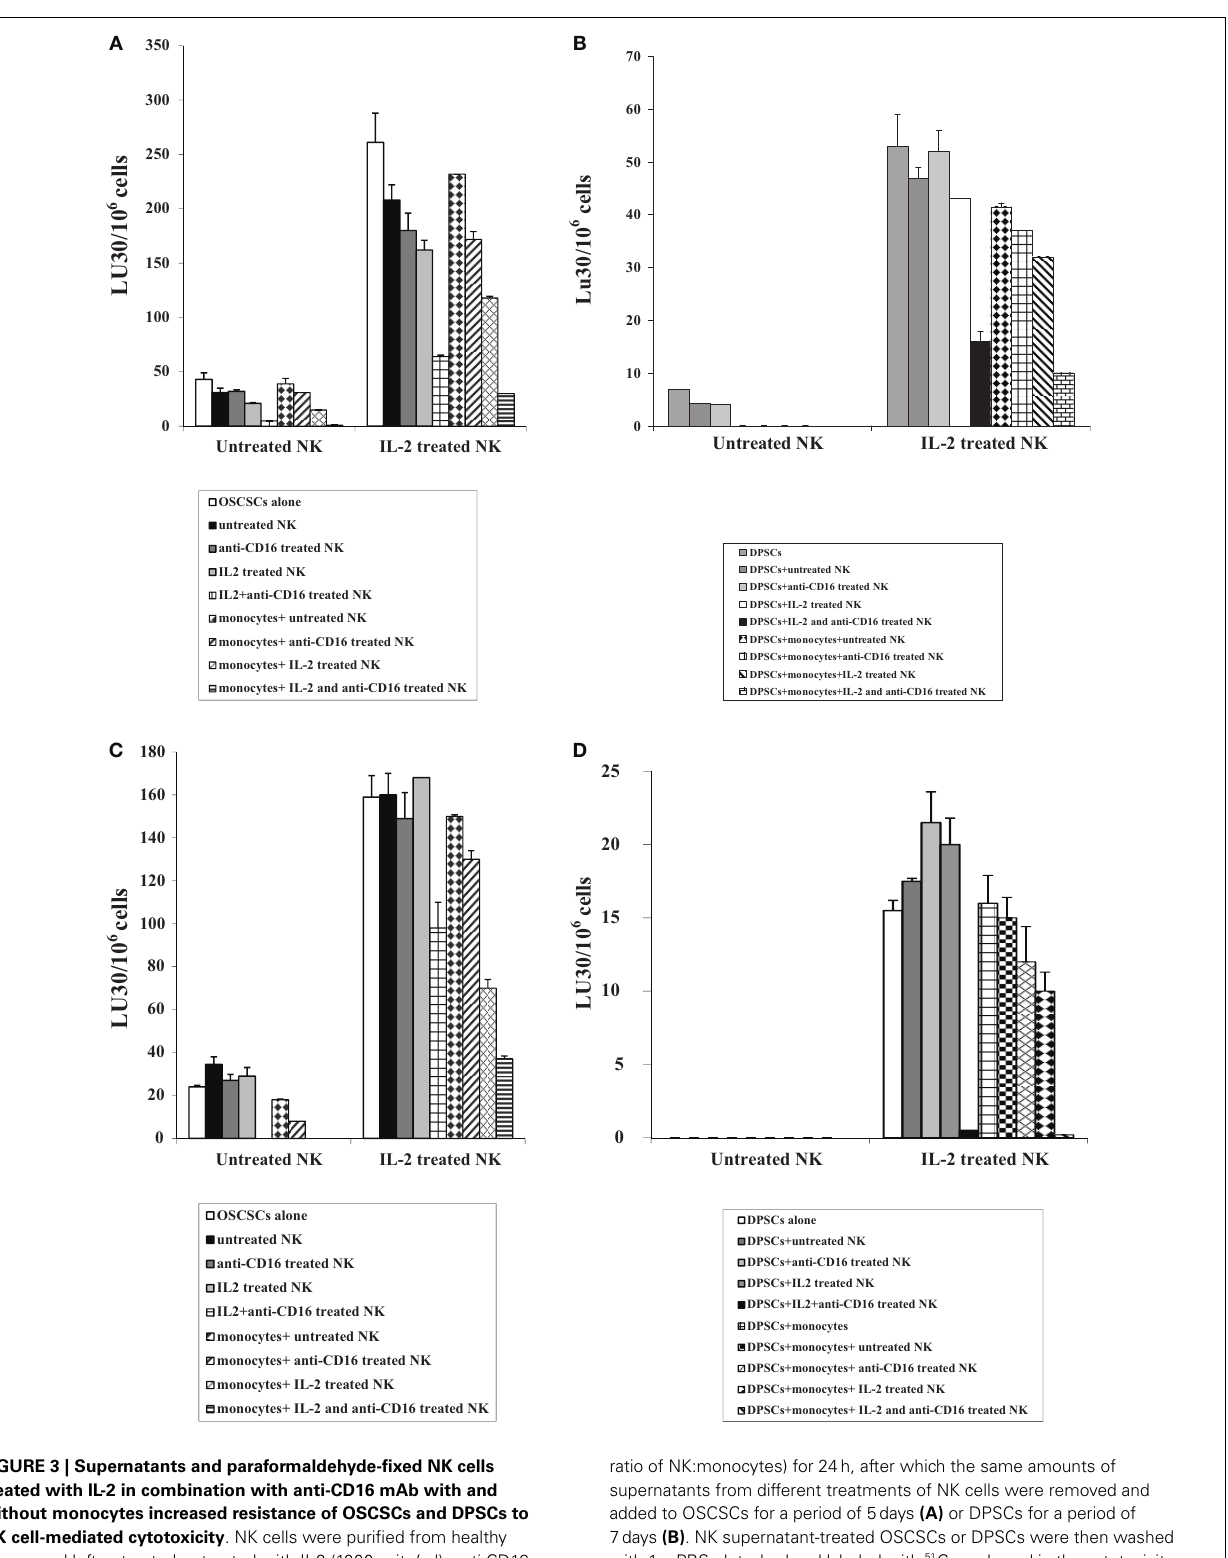
FIGURE 3 | Supernatants and paraformaldehyde-fixed NK cells treated with IL-2 in combination with anti-CD16 mAb with and without monocytes increased resistance of OSCSCs and DPSCs to NK cell-mediated cytotoxicity . NK cells were purified from healthy donors and left untreated or treated with IL-2 (1000units/ml), anti-CD16 mAb (3 µ g/ml), or the combination of IL-2 (1000units/ml) and anti-CD16 mAb (3 µ g/ml) in the presence or absence of autologous monocytes (1:1